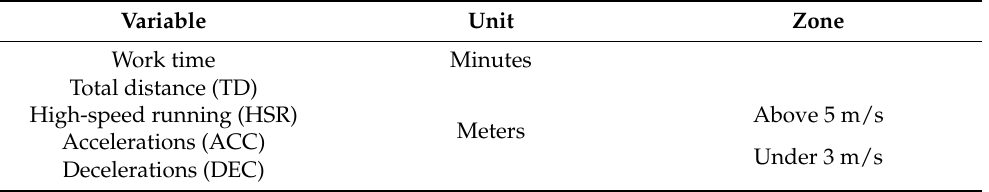
Table 1. GPS metrics measured in this study, their united, and